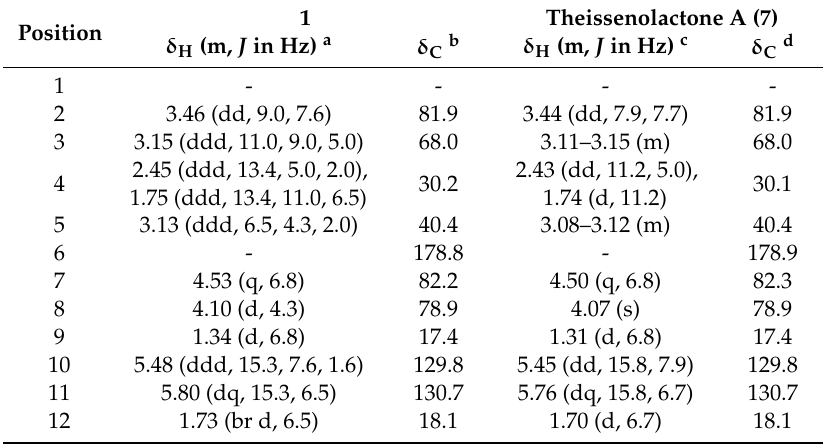
Table 3. Comparison of 1 H and 13 C-NMR data (CD 3 OD) of 1 with theissenolactone A. 1 Theissenolactone A (7) Position